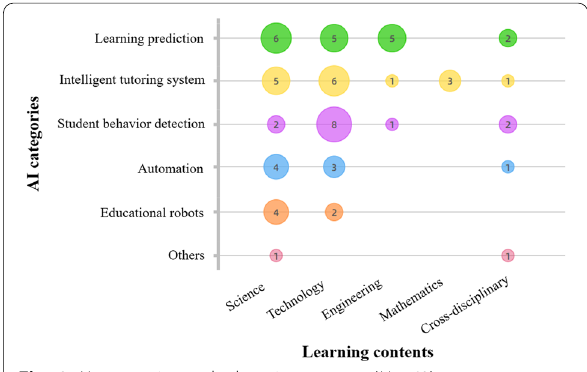
Fig. 6 AI categories under learning content ( N